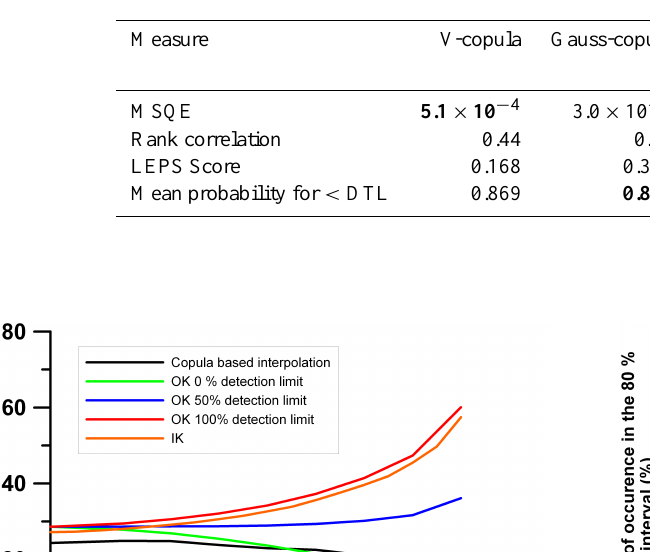
Table 4. Cross validation results for deethylatrazin.